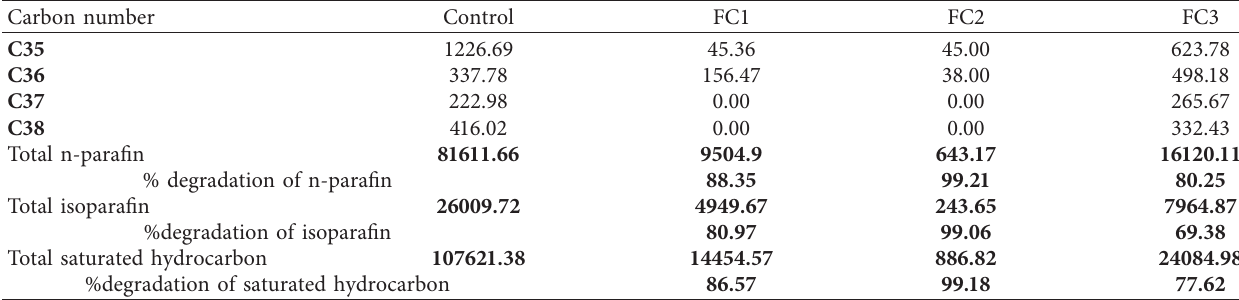
Total n-parafin